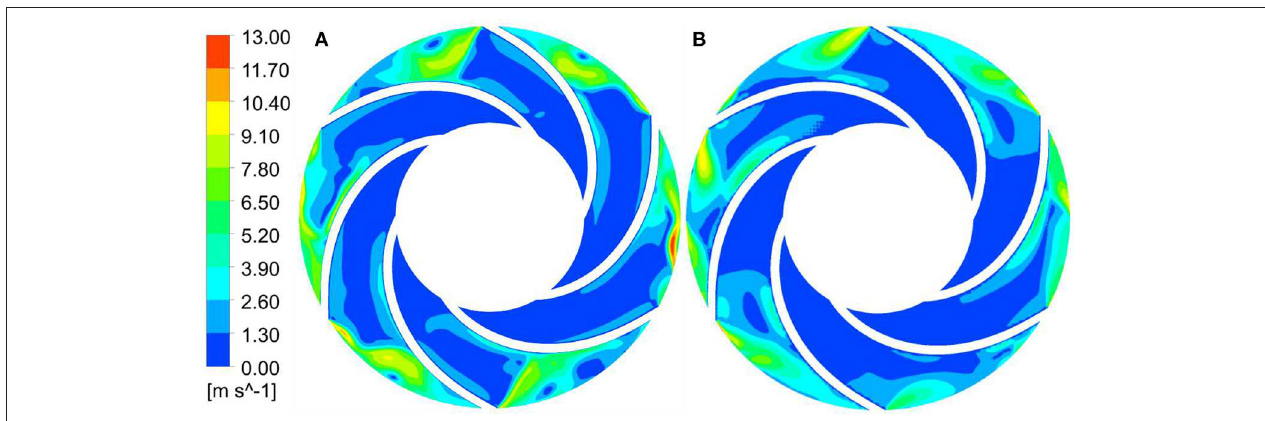
FIGURE 6 | Velocity distribution of the first stage impeller with n = 600 r/min. (A) Start-up transient of closed-valve and (B) steady state at the same speed.